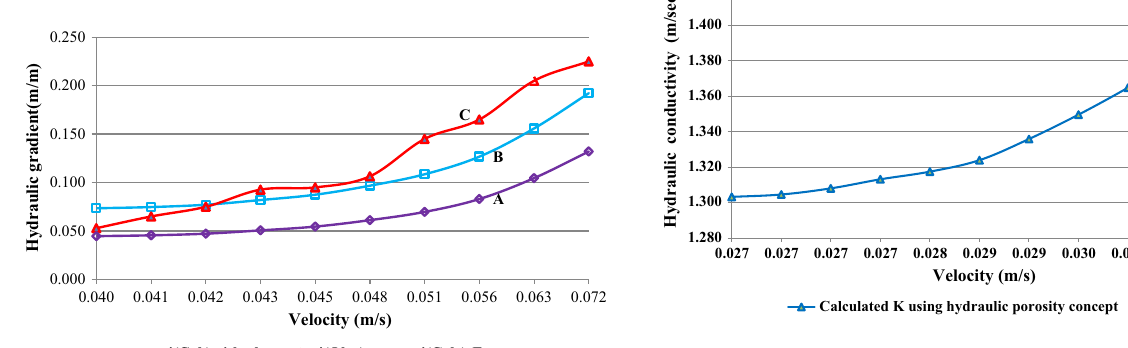
Fig. 15 Variation of hydraulic conductivity based on hydraulic poros- ity versus superficial velocity: CGM1 materials 4.8005.0005.2005.4005.6005.8006.000